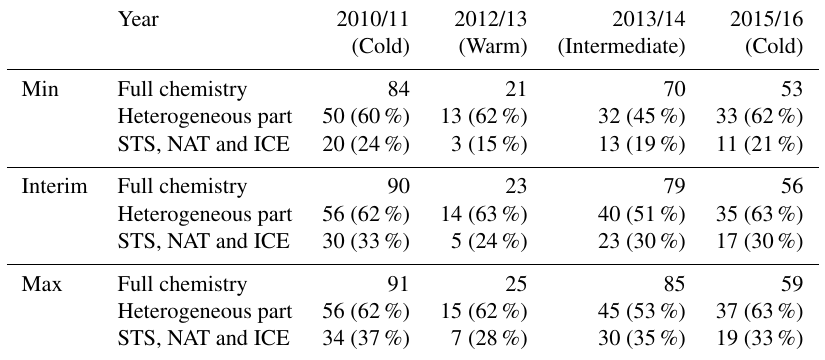
Table 3. Maximum polar vortex mean ozone loss produced by full chemistry, heterogeneous chemistry and separately by the STS, NAT and ICE part in Min, Max and Interim simulations (DU). Percentages show the fraction due to each part relative to the full